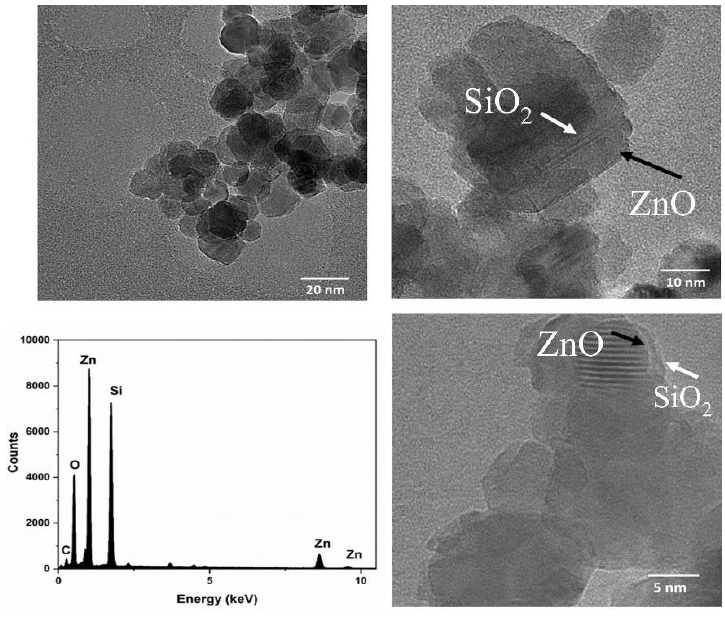
Figure 1. TEM images and the corresponding EDX spectrum of the SiO 2 -coated ZnO nanocrystals. Table 1. Weight and atomic percentages of the SiO 2 -coated ZnO nanocrystals.